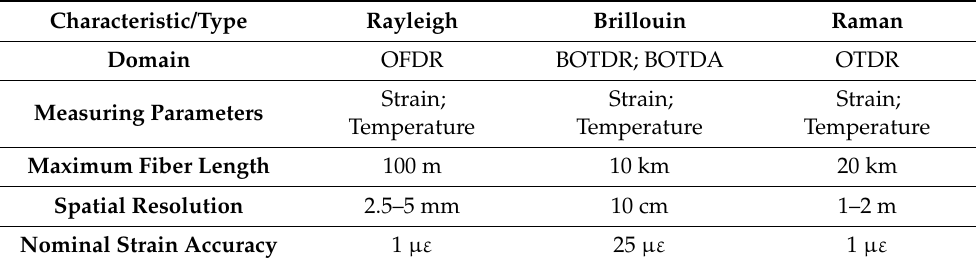
Table 1. Comparison of distributed fiber optic technologies.